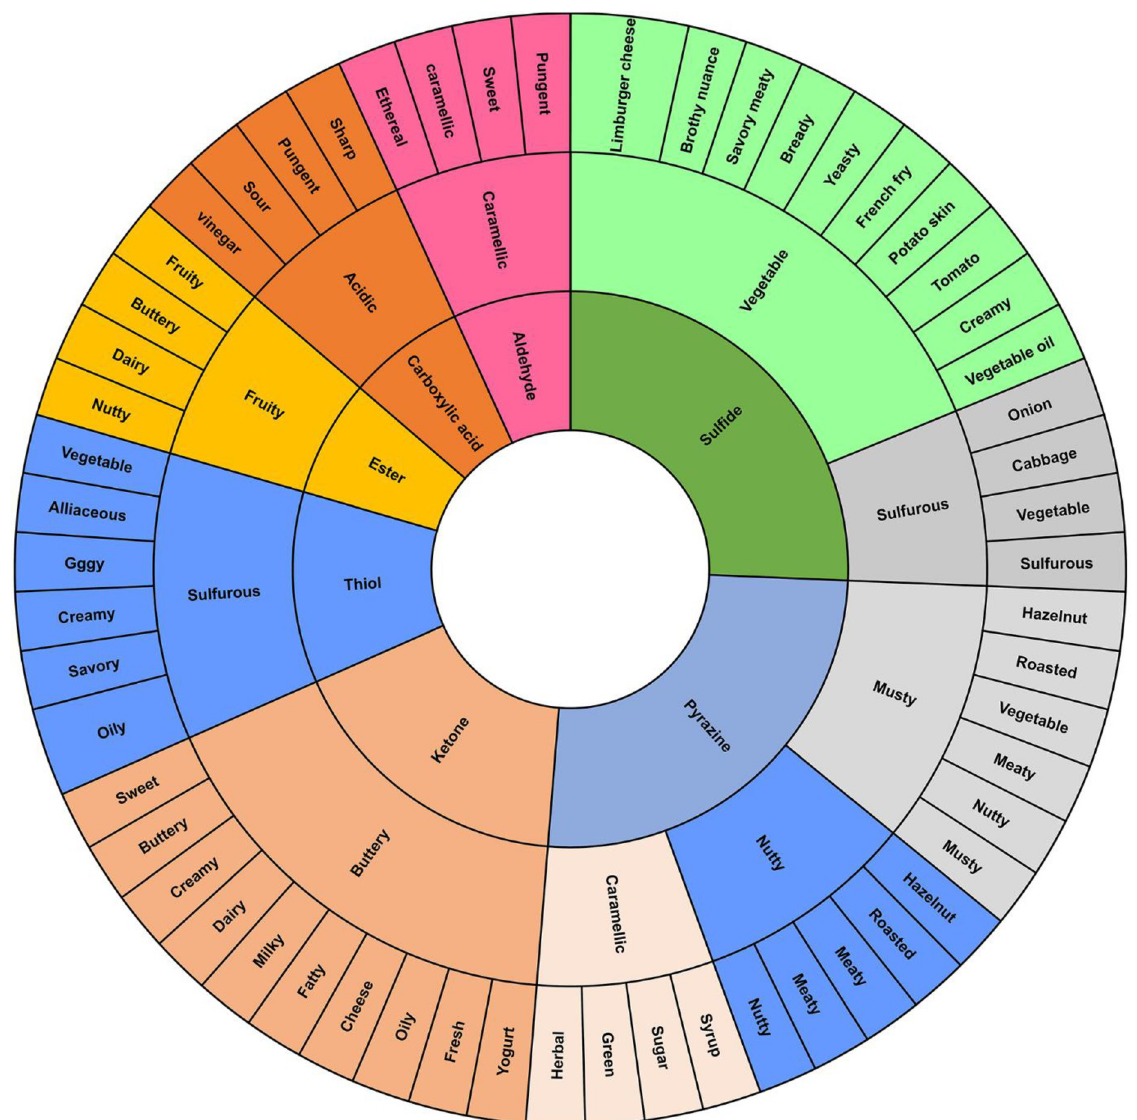
Fig 3. Flavor wheel of process flavorings extruded from methionine: dextrose: modified starch: water at the ratio of 56:14:25:5.